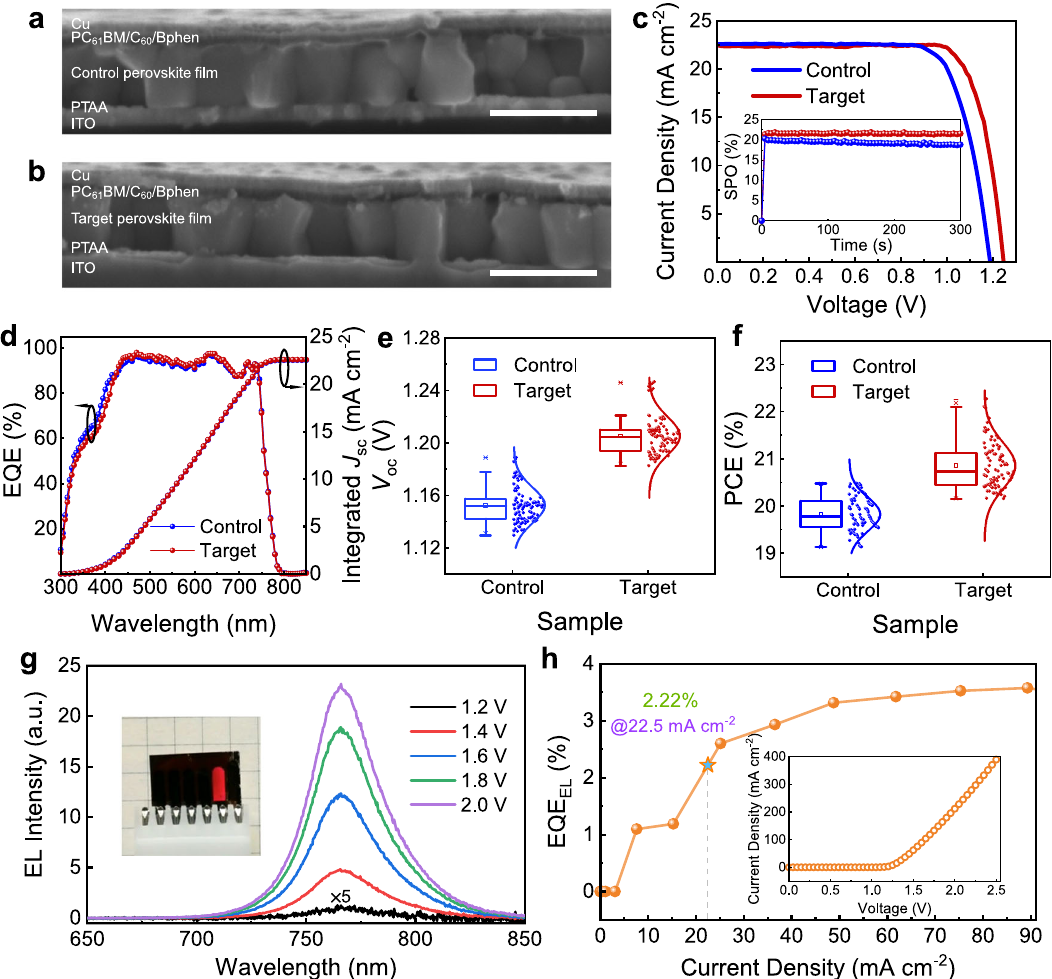
Fig. 5 Photovoltaic and device characterization. a , b Cross-sectional scanning electron microscopy (SEM) images of the full device with the control ( a ) and target ( b ) perovskite fi lms. Scale bar, 1 µ m. c J – V characteristic of champion devices, and stabilized power output (SPO) of these cells at the maximum power point under simulated AM 1.5 G illumination (inset). d External quantum ef fi ciency (EQE) spectra and the integrated short-circuit current